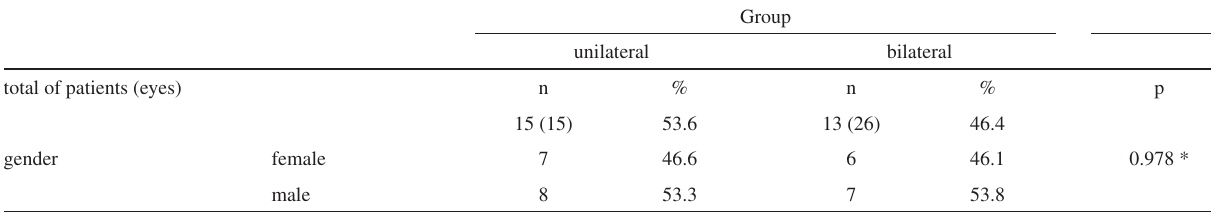
Table 1 - Patients characteristics. There is no variation in prevalence related to